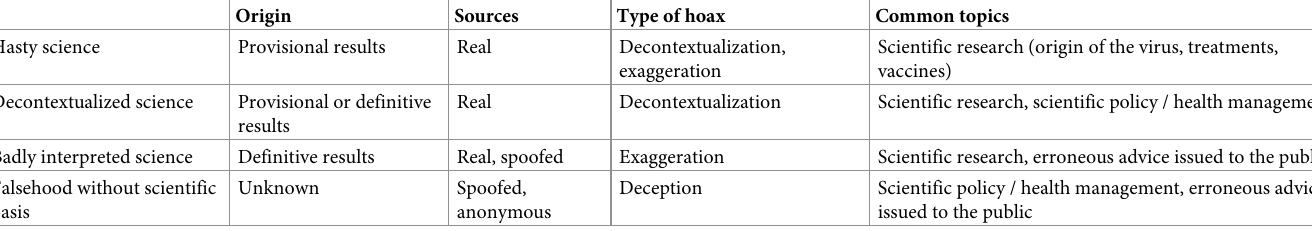
Table 14. Classification of science and health-related hoaxes according to their connection to scientific